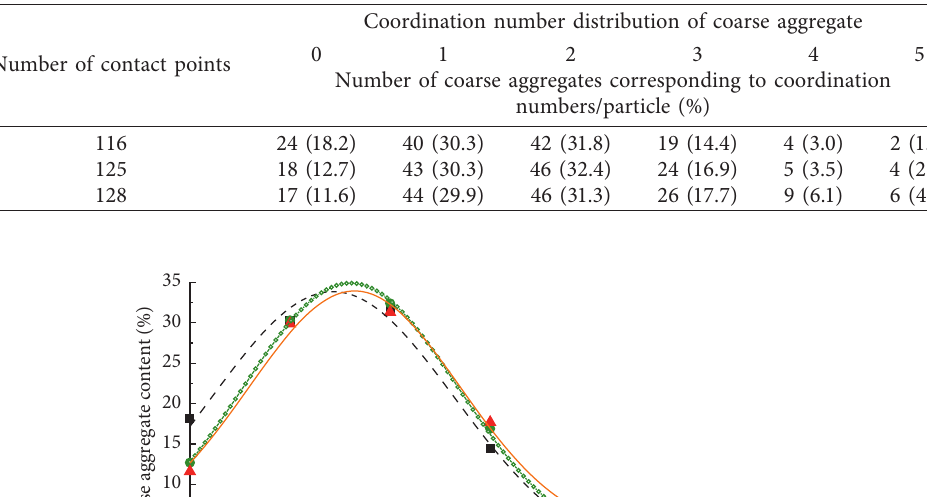
Table 7: Coordination number distribution of coarse aggregate.